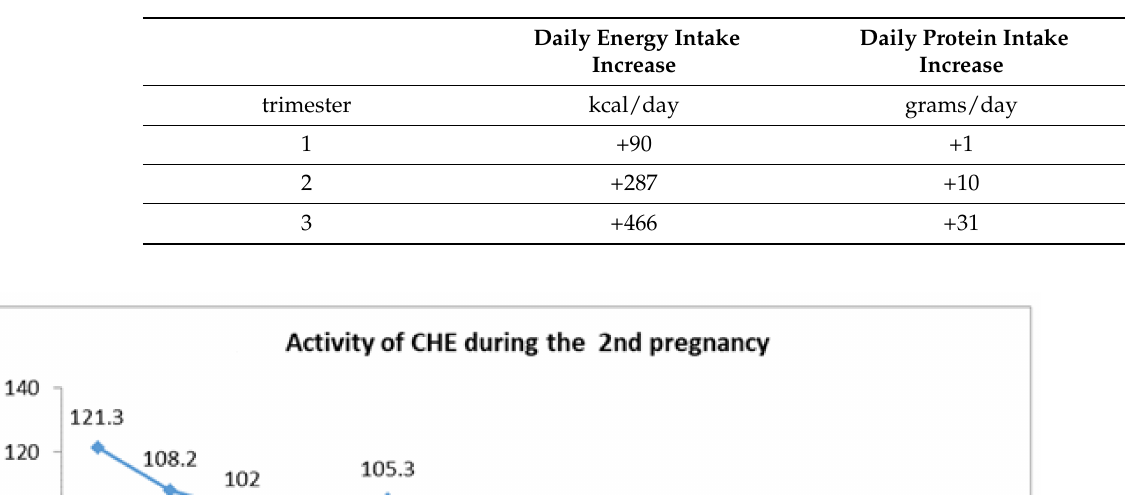
Table 1. Recommended amounts of gradual increase of energy and protein intake during pregnancy compared to a regular diet of patients with OTC deficiency (Haberle 2012).